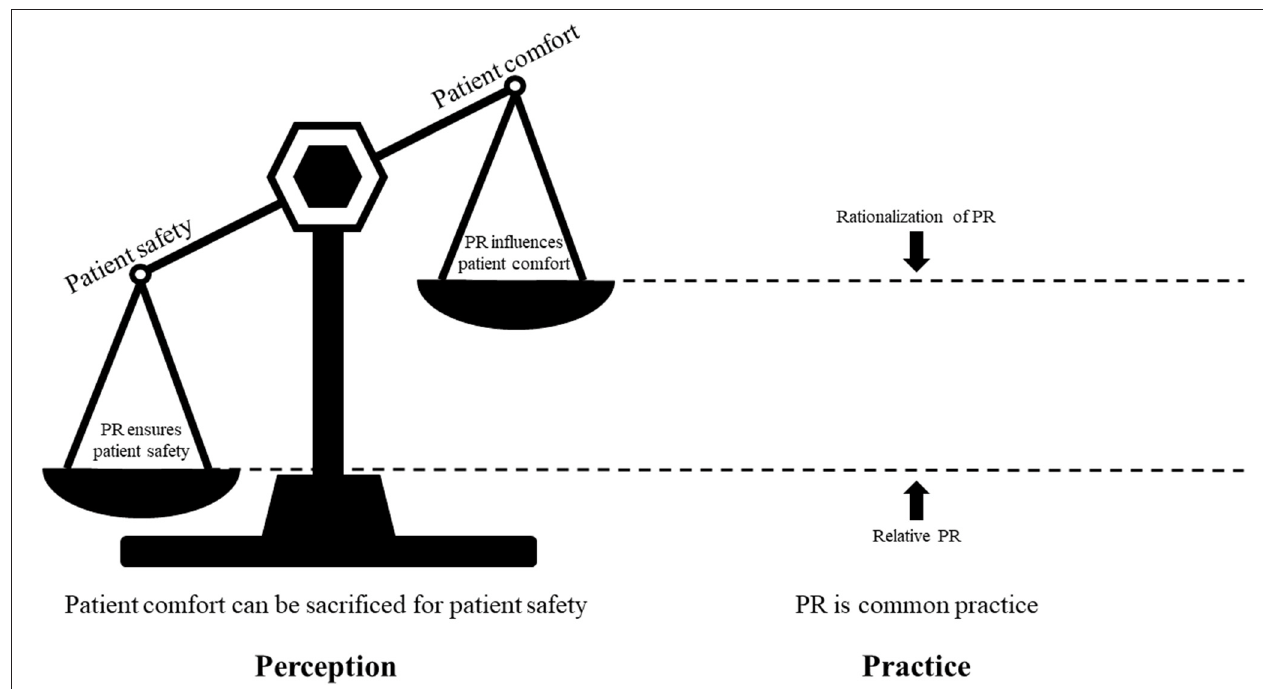
FIGURE 1 | Relationship between themes and subthemes. Nurses consider that patient safety is more important, leading to common practice of physical restraints. Relative physical restraints and rationalization of physical restraints become strategies to cope with imbalance between patient safety and patient comfort. PR, physical